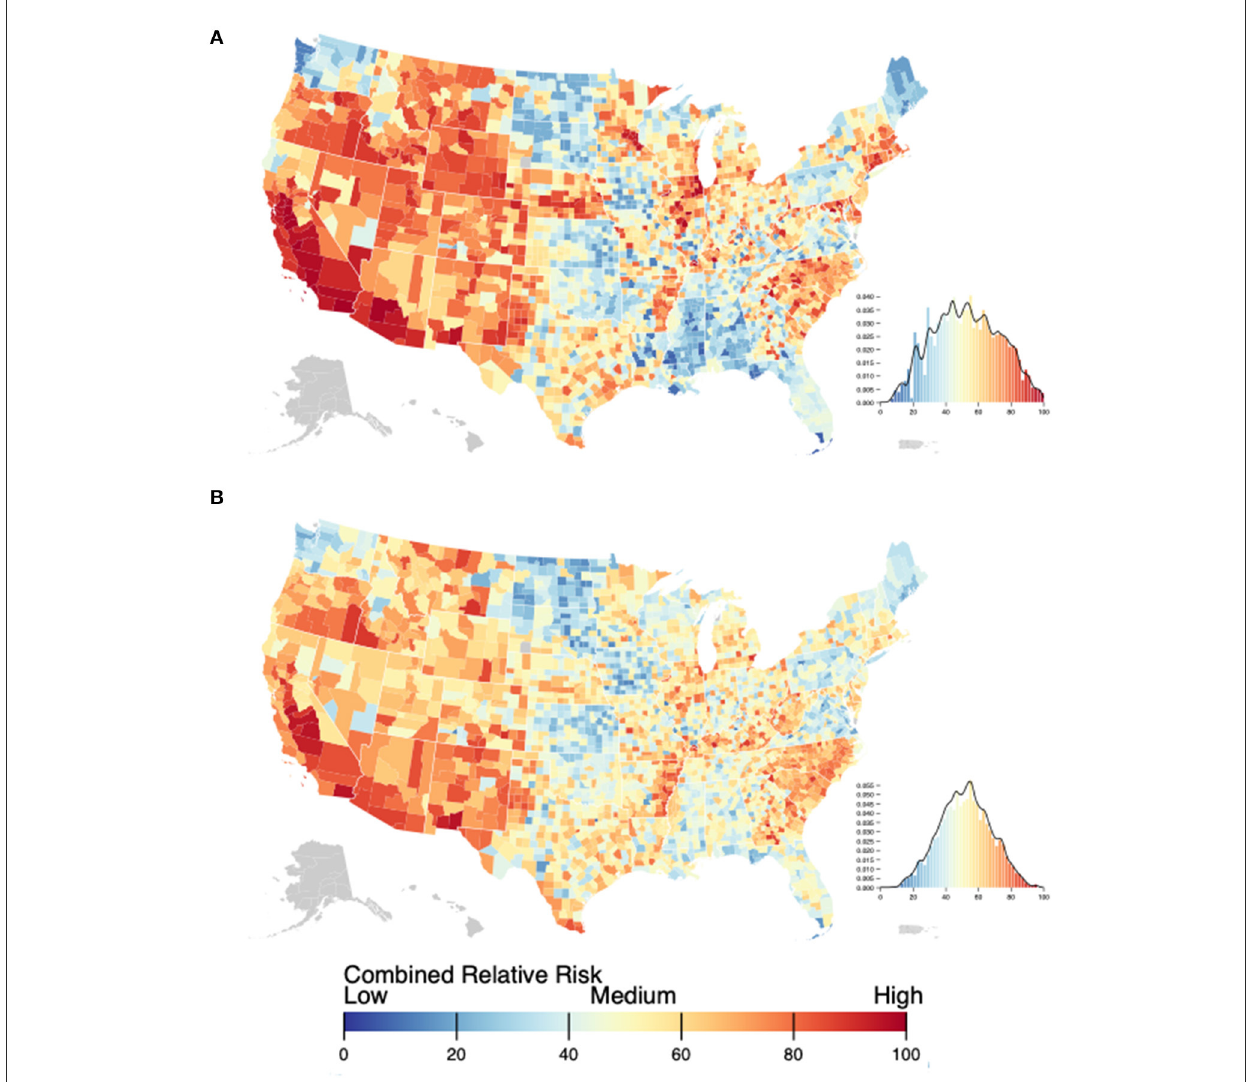
FIGURE5 As in Figure 3, but highlighting the contrast between combinatory landscapes of: (A) water stress and water quality risks; and (B) water stress, water quality, and population below the poverty level.